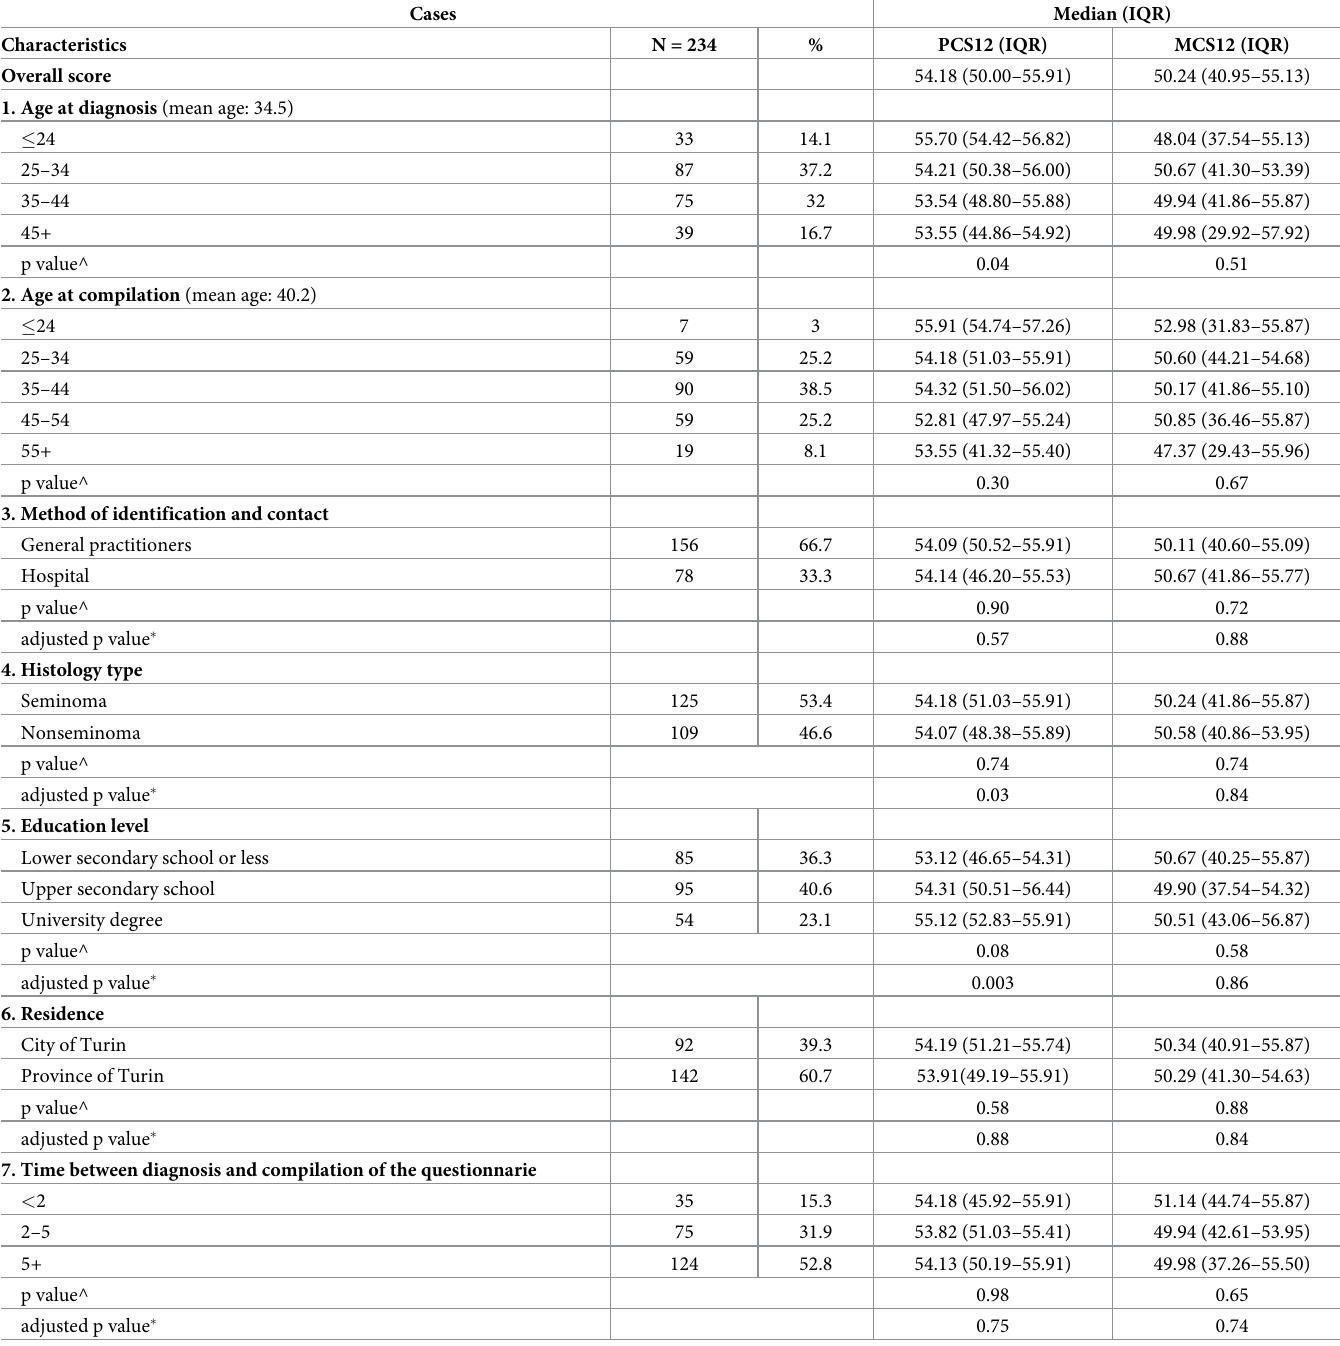
Table 2. Physical and mental component scores distribution by cases’